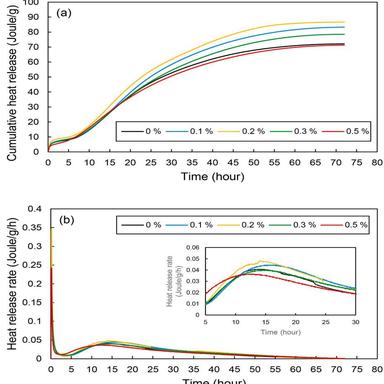
(a) Cumulative heat release and (b) heat release rate of the samples during the initial 72 h of hydration.